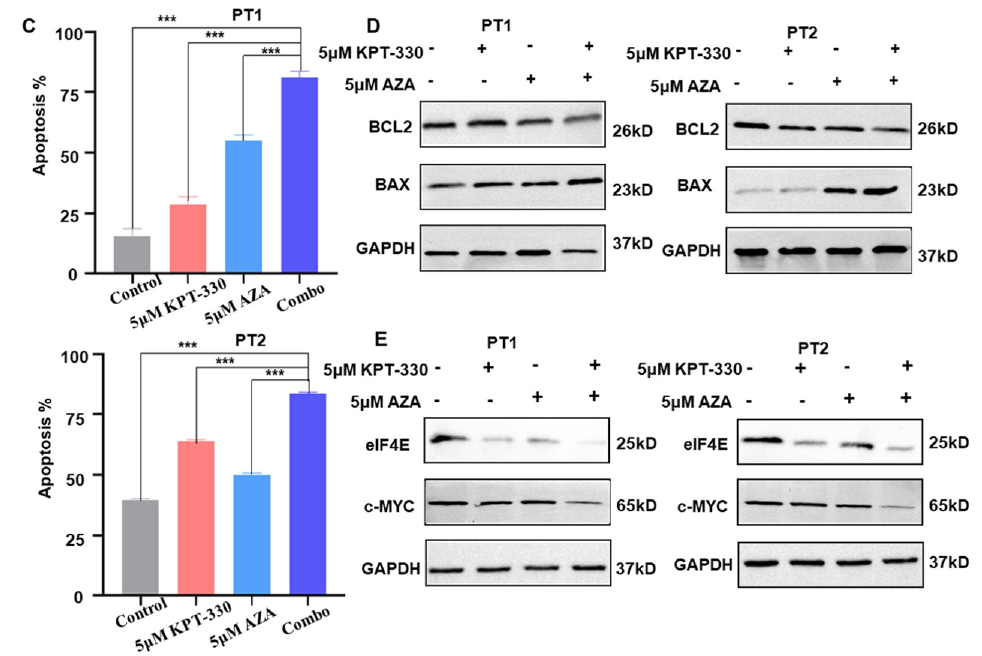
Figure 8. Synergistic effect of KPT-330 with AZA on apoptosis in primary cells from the AML patients. ( A ) Effect of drug treatment (DMSO, KPT-330, AZA, and combo) on apoptosis in primary cells from AML patient 1 (PT1). ( B ) Effect of drug treatment (DMSO, KPT-330, AZA, and combo) on apoptosis in primary cells from AML patient 2 (PT2). ( C ) Quantitative bar chart for PT1 and PT2. ( D ) Effect of drug treatment (DMSO, KPT-330, AZA, and combo) on apoptosis-related protein (BCL2 and BAX) in primary cells from AML PT1 and PT2. ( E ) Effect of drug treatment (DMSO, KPT- 330, AZA, and combo) on XPO1, elF4, and c-MYC in primary cells from AML patient PT1 and PT2. *** p < 0.001